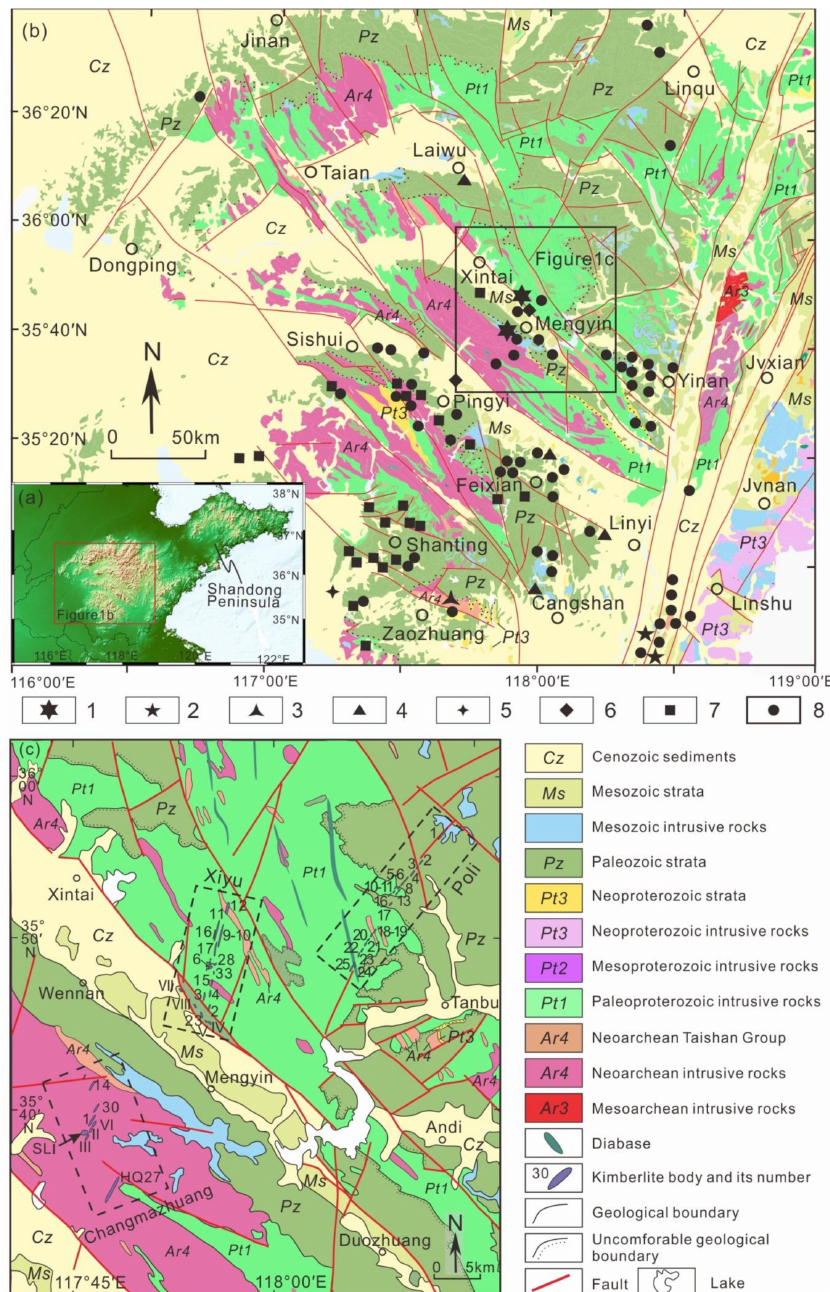
Figure 1. ( a ) Simplified topographic map of Shandong Peninsula. ( b ) Distribution map of kimberlite- hosted diamonds and alluvial rocks-derived diamonds in Shandong Province. 1-kimberlite-hosted diamond; 2-Alluvial diamond; 3-Diamond-bearing conglomerate in Cambrian Liguan Formation; 4-Diamond-bearing conglomerate in Carboniferous Benxi Formation; 5-Diamond-bearing conglomer- ate in Jurassic Sanhe Formation; 6-Diamond-bearing conglomerate in Paleogene Gucheng Formation; 7-Diamond-bearing conglomerate in Neogene-Quaternary Baiyan Formation; 8-Diamond-bearing Quaternary conglomerate [16]; ( c ) Geological map of diamonds hosted in the Changmazhuang, Xiyu and Poli kimberlite belts in Mengyin deposit. Greek numbers I, II, III and VI in the Changmazhuang belt and IV, V, VII and VIII in the Xiyu belt should be preceded by Shengli (means victory, SL in short) as SL I–VIII; Roman numbers 1–30 in the two belts should be preceded by Hongqi (means red flag, HQ in short) as HQ1–30; Roman numbers 1–25 in the Poli belt should be preceded by K as K1–25 to number kimberlite